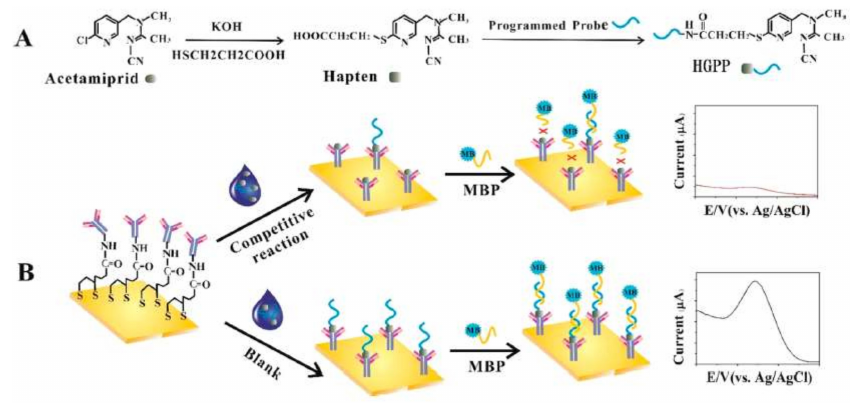
Figure 7. ( A ) Preparation of HGPP. ( B ) Competitive immunosensor assay for the detection of acetamiprid (reprinted with permission from